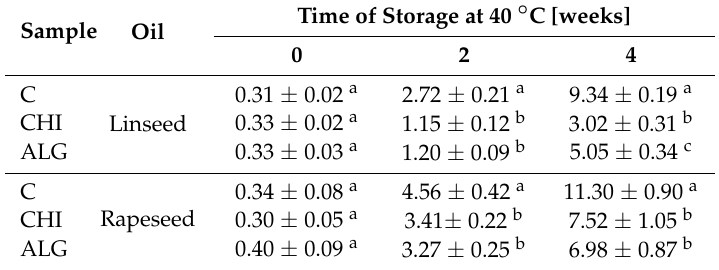
Values in individual lines marked with the same letters do not differ significantly ( p < 0.05, n = 3).